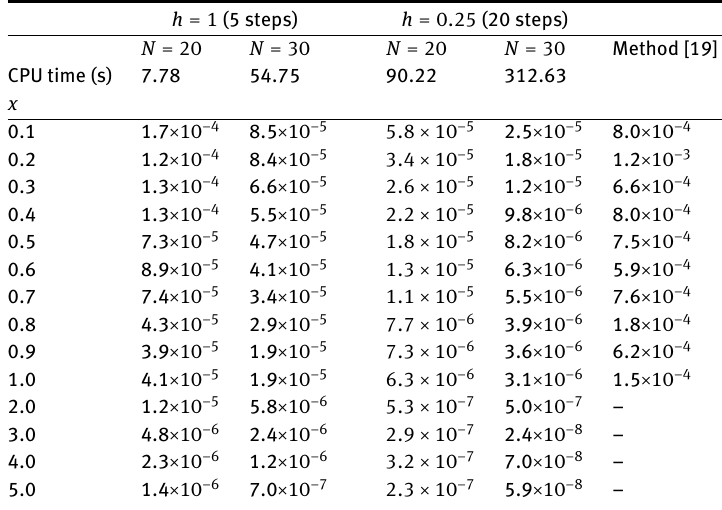
Table 1: Absolute errors for α = 0.85 in the interval [0, 5] for Example 1.